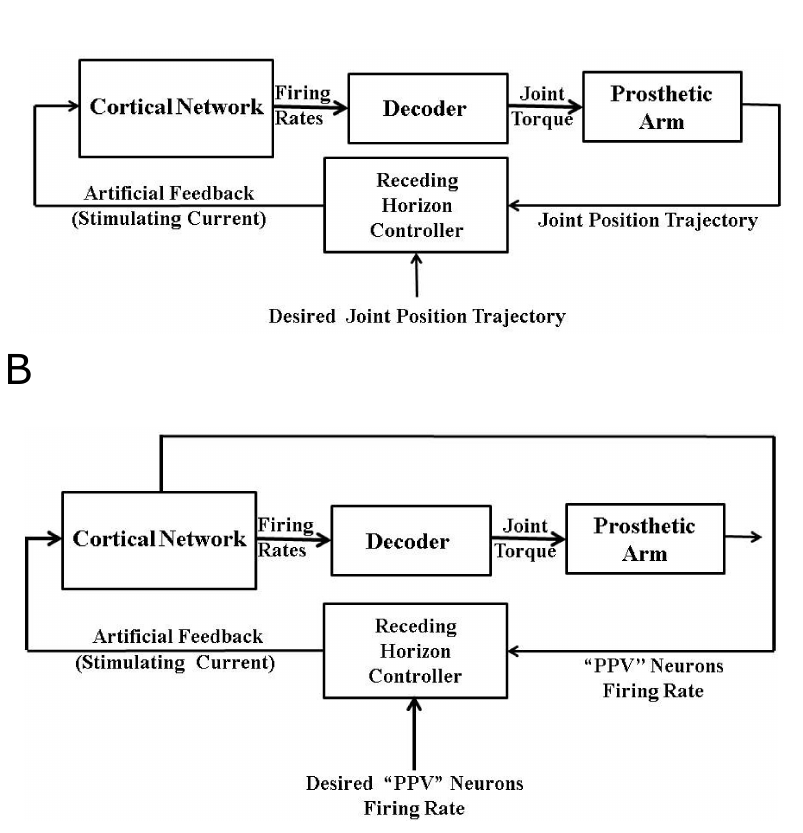
Figure 9. Model Predictive Control (MPC) based closed-loop BMI for Problem 1 and Problem 2. ( A ) shows the design for “Problem 1”. Here the model predictive controller designs the “Artificial Feedback” to stimulate “PPV” neurons such that the system output (“Single Joint Position” trajectory) mimics the “Desired Joint Position” trajectory; ( B ) shows the design for “Problem 2”. Here the model predictive controller designs the “Artificial Feedback” to stimulate “PPV” neurons such that the system output (“PPV Neurons Firing Rate” ) mimics the “Desired PPV Neurons Firing